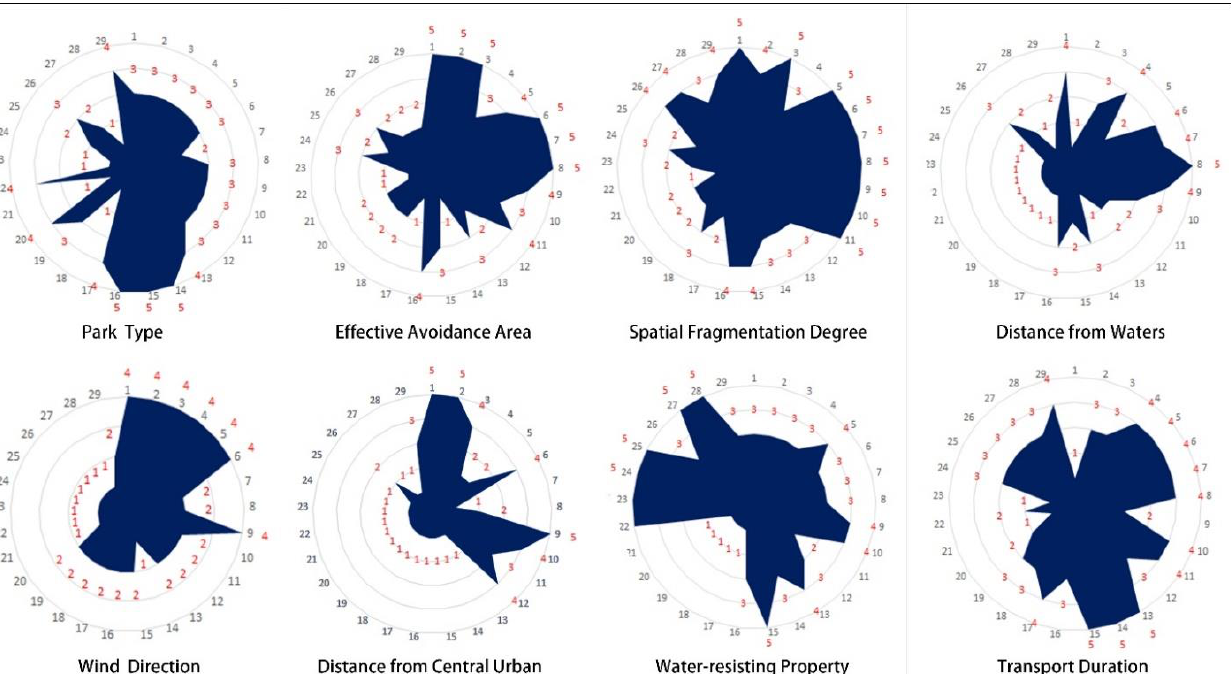
Table 8. The results of park type assignment of country parks.